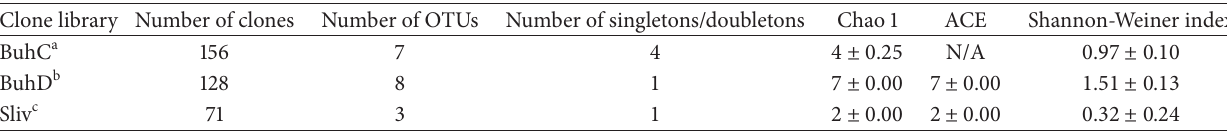
Table 2: Predicted richness (Chao 1 and ACE) and diversity (Shannon-Weiner index) of BuhC, BuhD, and Sliv 16S rDNA archaeal clone libraries, expressed as means ± standard deviation.